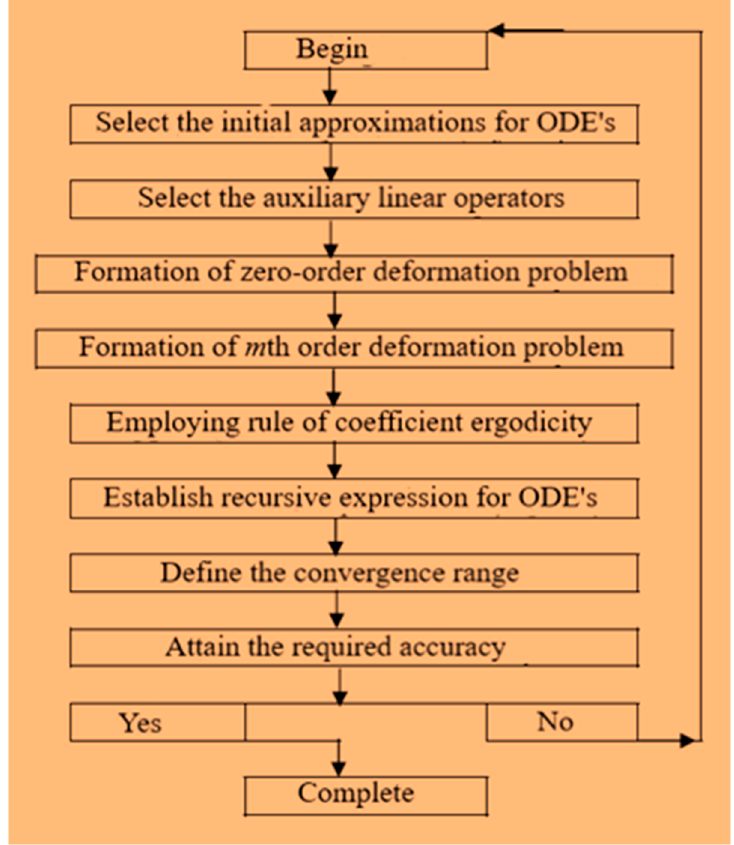
Chart 1. Flow chart of HAM expression.